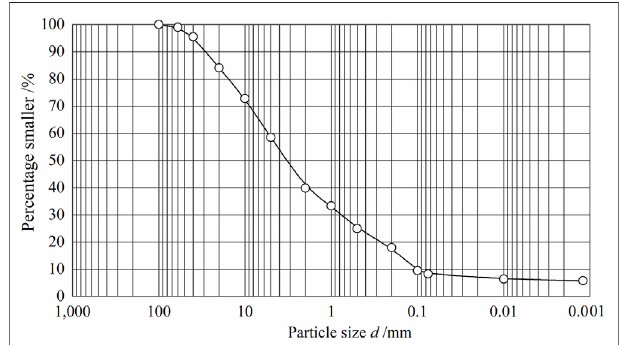
FIGURE 4 | Distribution of particle size of sliding zone.